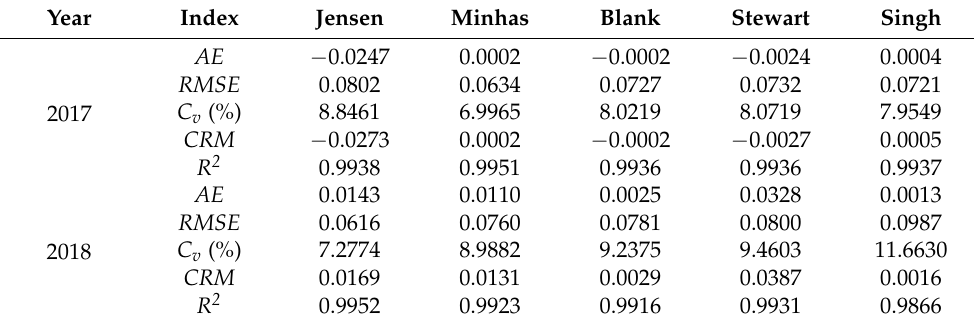
Table 5. Simulation accuracy analysis of the five WPFMs in 2017 and